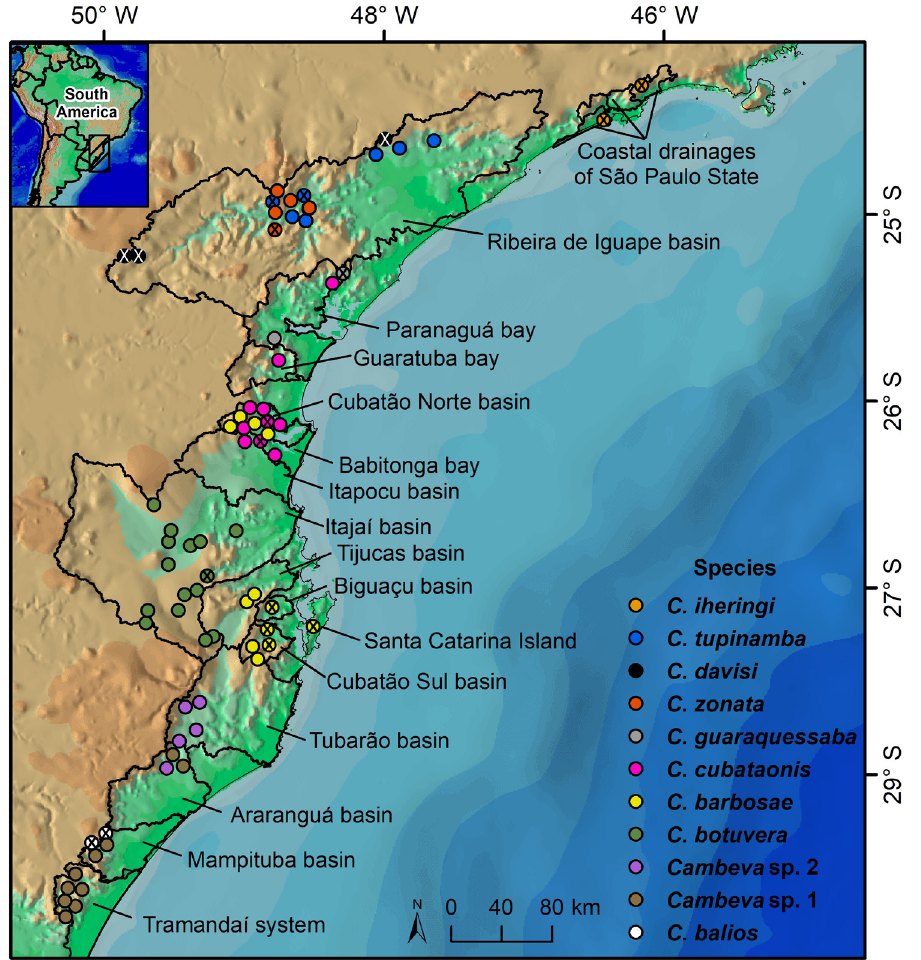
FIGURE 1 | Geographical distribution of Cambeva species in the coastal drainages of Southern and Southeastern Brazil (crossed circles indicate their past known distribution). Some dots represent more than one